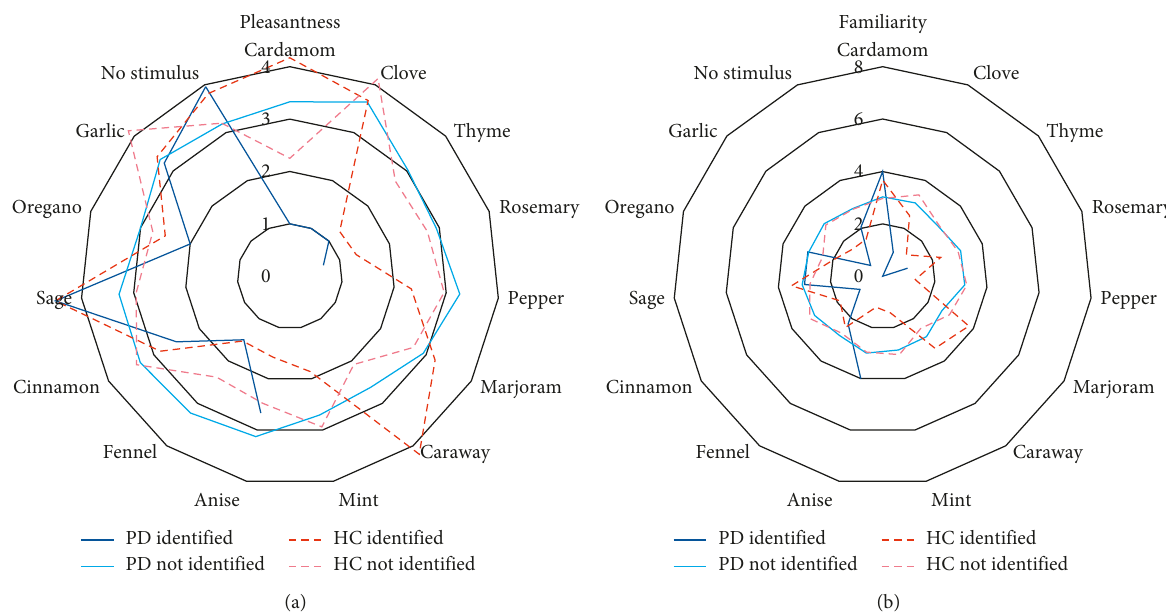
Figure 4: Correlation between pleasantness (a) and familiarity (b) of an odorant and its identification by Parkinson’s patients and healthy controls; results are shown as mean; PDidentified, Parkinson’s patients who correctly identified the odorant; PDnotidentified, Parkinson’s patients who did not correctly identify the odorant; HCidentified, healthy controls who correctly identified the odorant; HCnotidentified, healthy controls who did not correctly identify the odorant; in Figure 3(a), 0 represents very pleasant and 4 represents not pleasant; in Figure 3(b), 0 represents very familiar, whereas 8 represents not